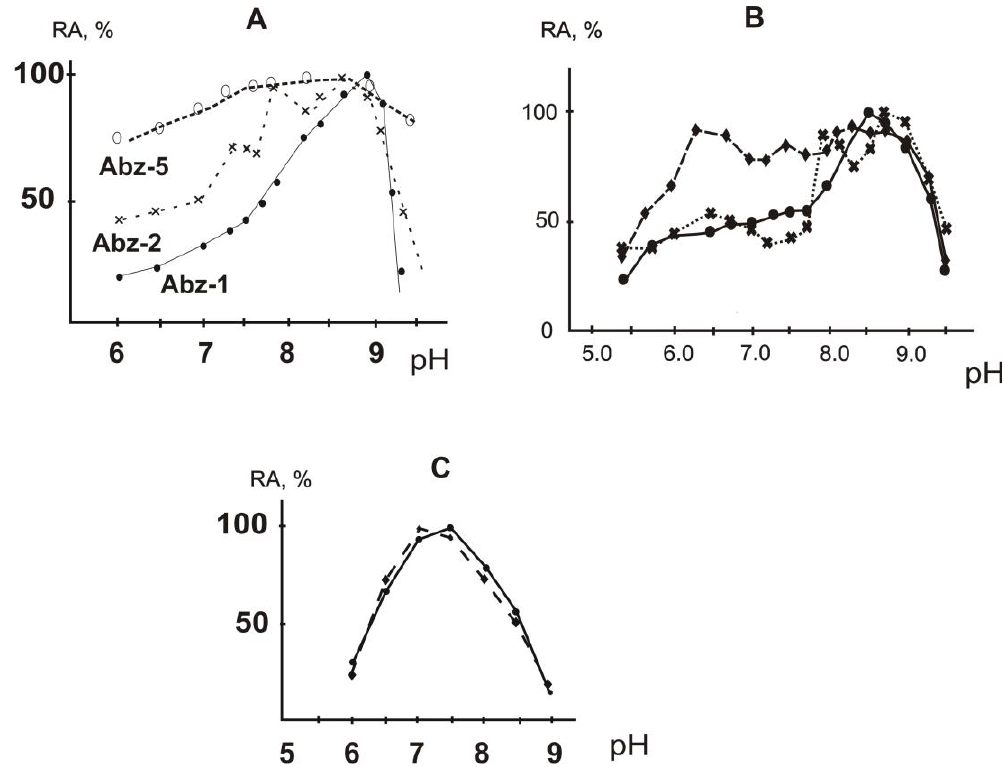
FIGURE 6 . pH dependence of the relative RNase activity of human blood RNases and IgGs and IgMs from the sera of six SLE patients in the hydrolysis of [5’- 32 P](pA) 13 oligonucleotide. Results for three electrophoretically and immunologically homogeneous IgGs (A) and IgMs (B), and human sera RNase 3 (  ) and RNase 4 (▪) (C), are